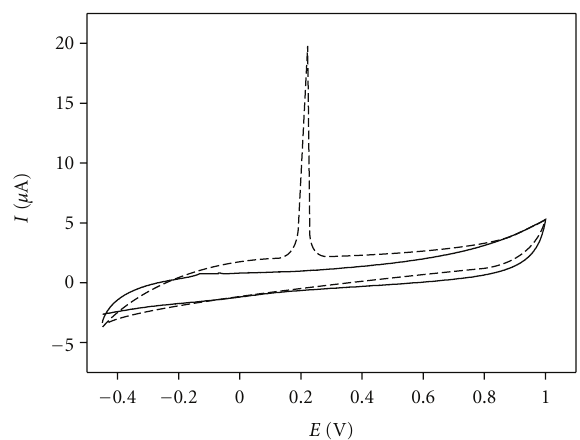
Figure 1: Cyclic voltammograms of blank solution (solid line) and 5 × 10 − 7 moLL − 1 of Hg 2+ at AAP modified GC electrode (dashed line). Electrolyte: 0.1molL − 1 HAc + 0.1mol L − 1 NaCl (pH